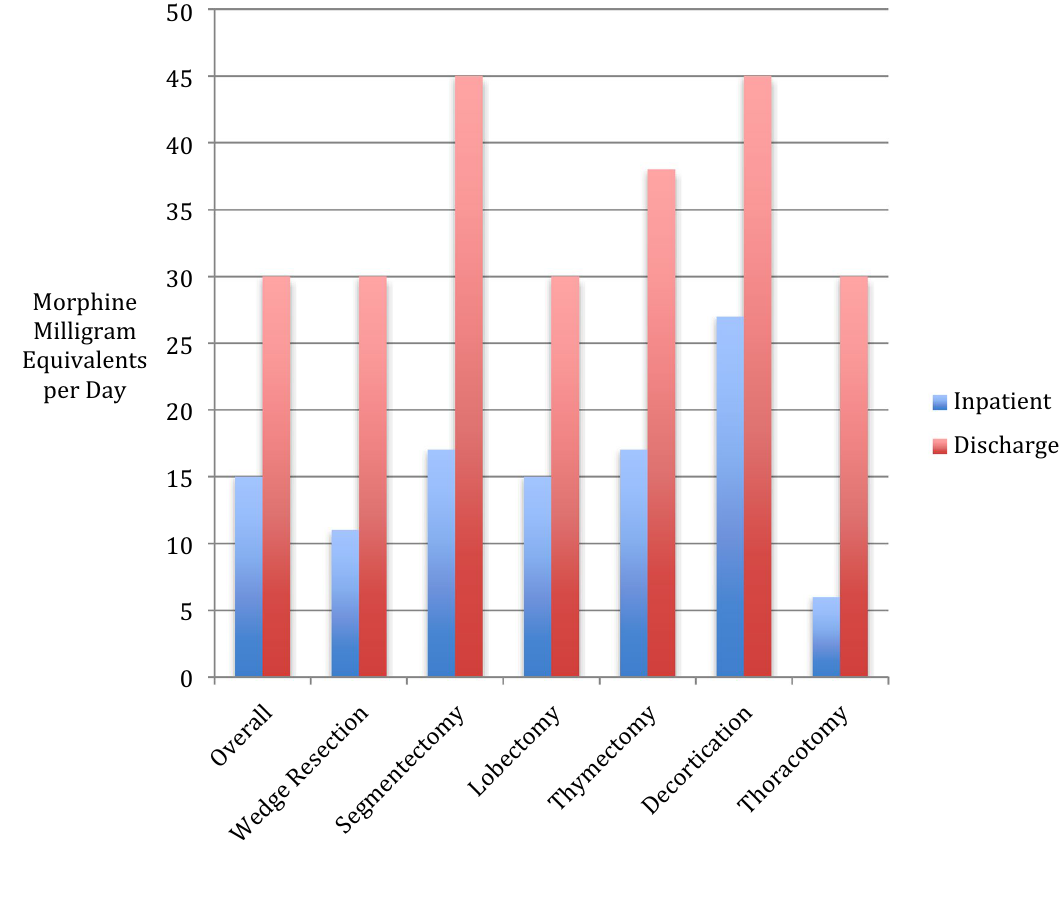
Figure 1. Median inpatient opioid use and prescribed opioids at discharge after thoracic